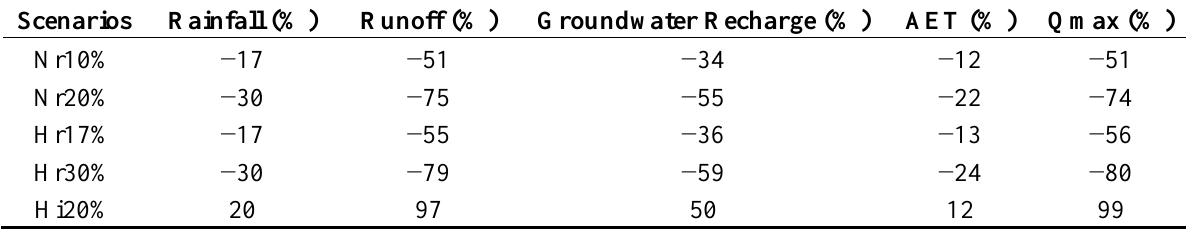
Table 3. Relative variations of the hydrological components with GR2M under the five scenarios of the changes in the rainfall field.